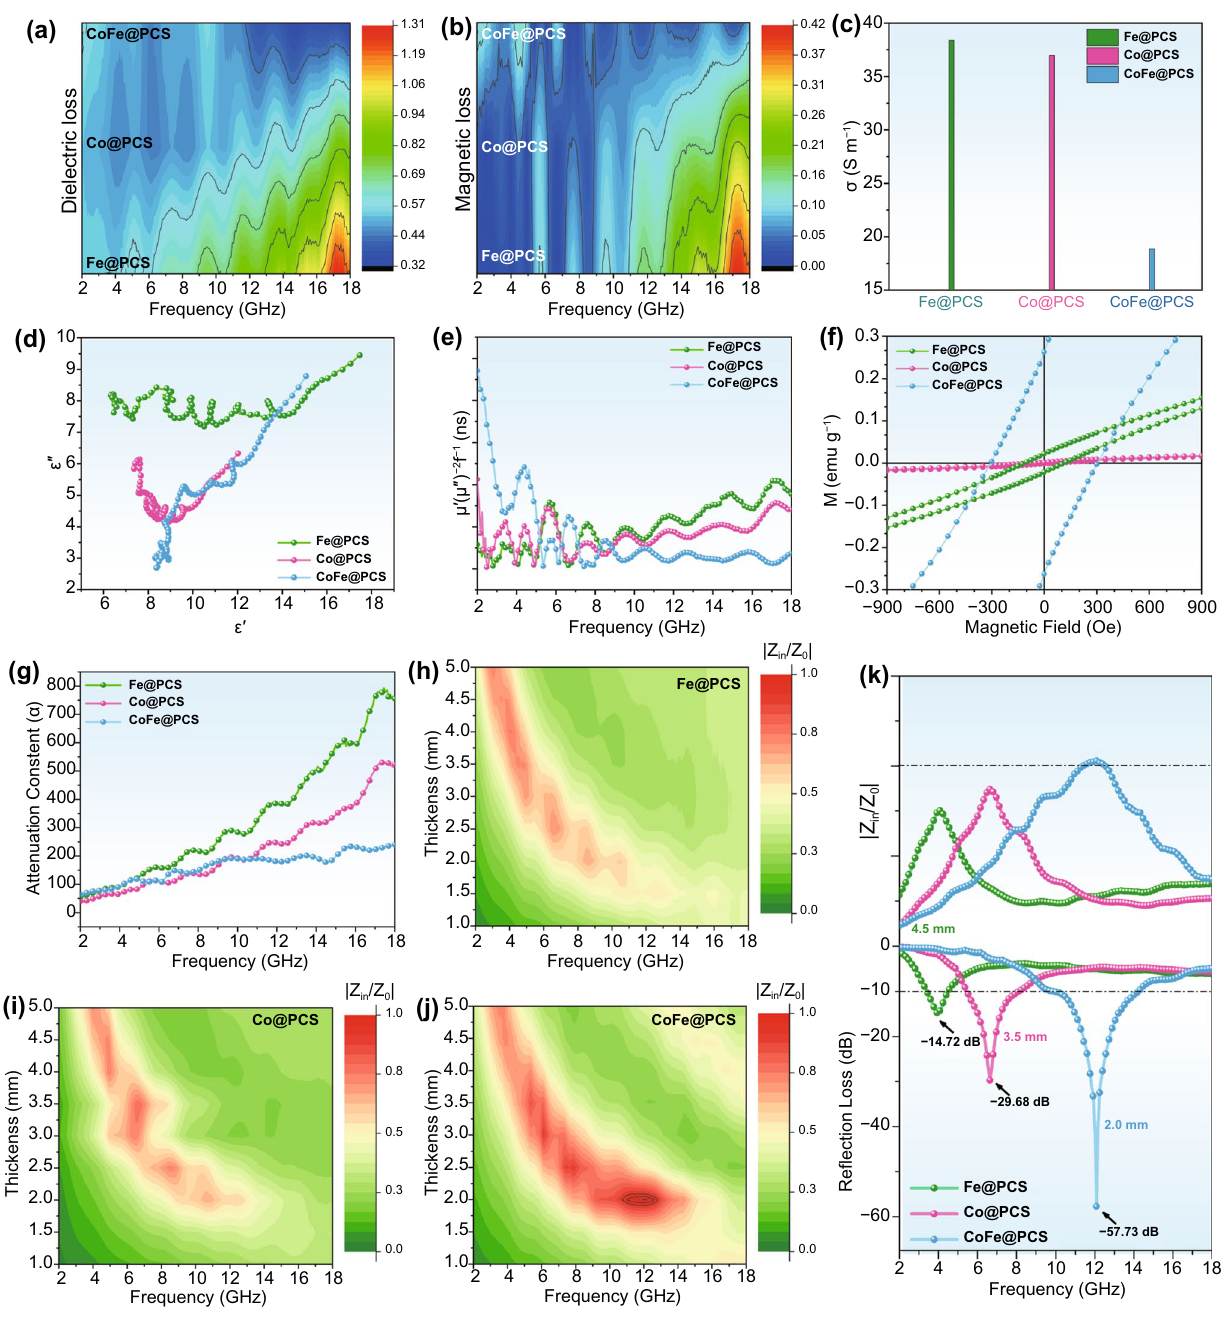
Fig. 3 EW attenuation and impedance matching analysis. a 2D contour map of tan δ ε for dielectric loss. b 2D contour map of tan δ μ for mag- netic loss. c Attenuation constant. d Electrical conductivity. e Cole–Cole semicircle. f C 0 value. g Magnetic hysteresis loop. h‑j 2D contour maps of | Z in / Z 0 |. k Best R L values and corresponding | Z in / Z 0 | for Fe@PCS, Co@PCS, and CoFe@PCS